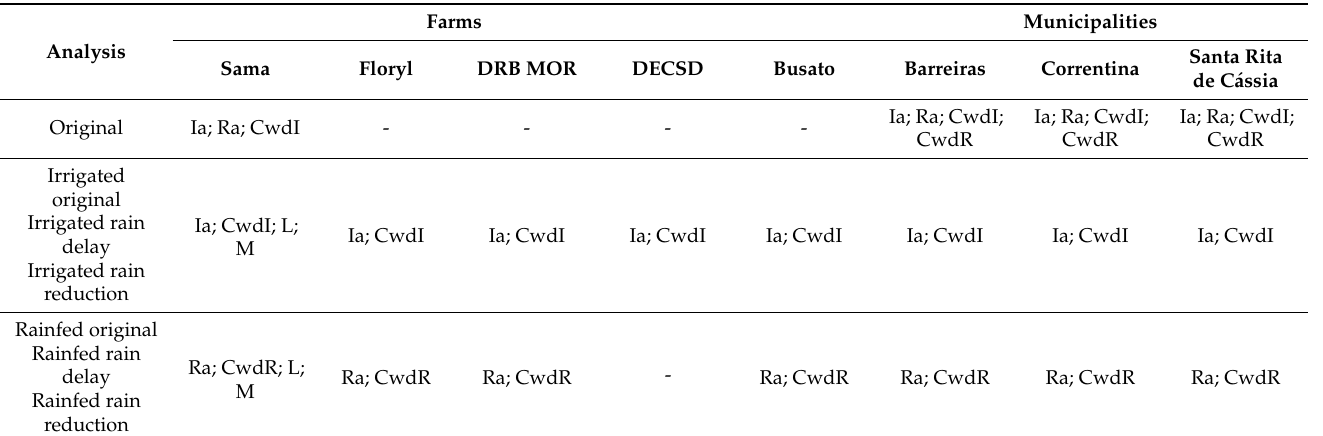
Table 4. Constraint setup for each LPM application and